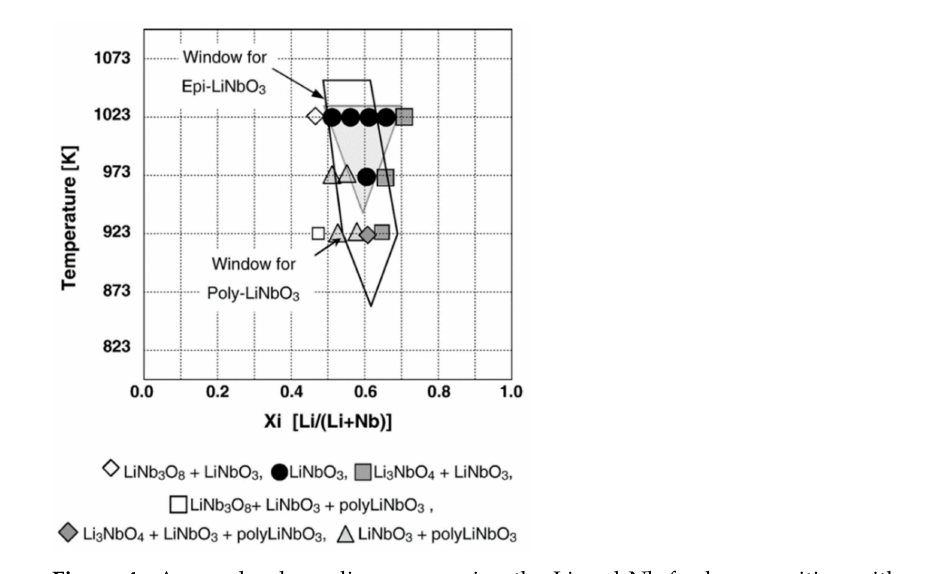
Figure 4. A pseudo-phase diagram varying the Li and Nb feed composition with growth tem- perature that shows growth windows for single and multiple phase LN epitaxy via MOCVD by Akiyama et al.